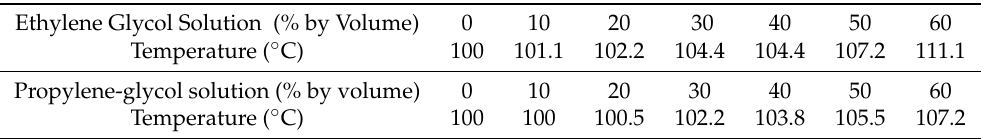
Table 2. Boiling points of ethylene-glycol- and propylene-glycol-based water solutions at various temperatures [2].